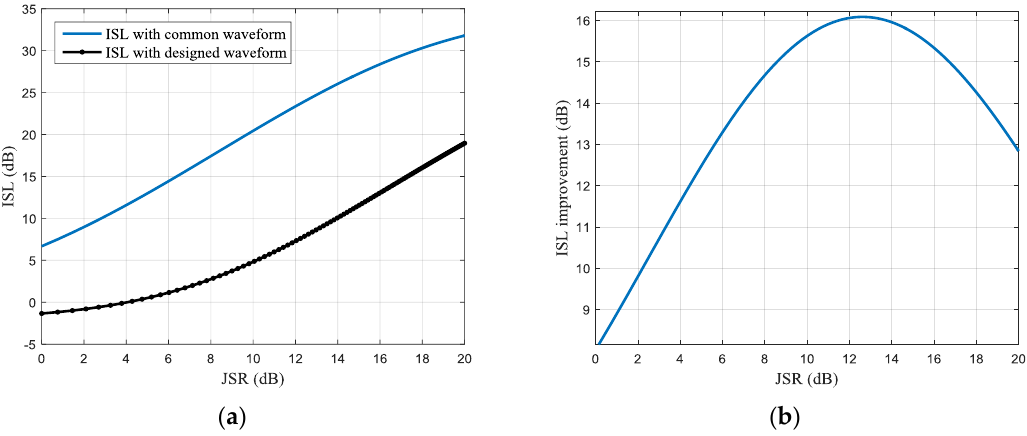
Figure 11. Integrated side-lobe level (ISL) of the pulse compression result under different JSR ( a ) ISL of the pulse compression result with common and designed waveforms ( b ) ISL improvement with different JSR.